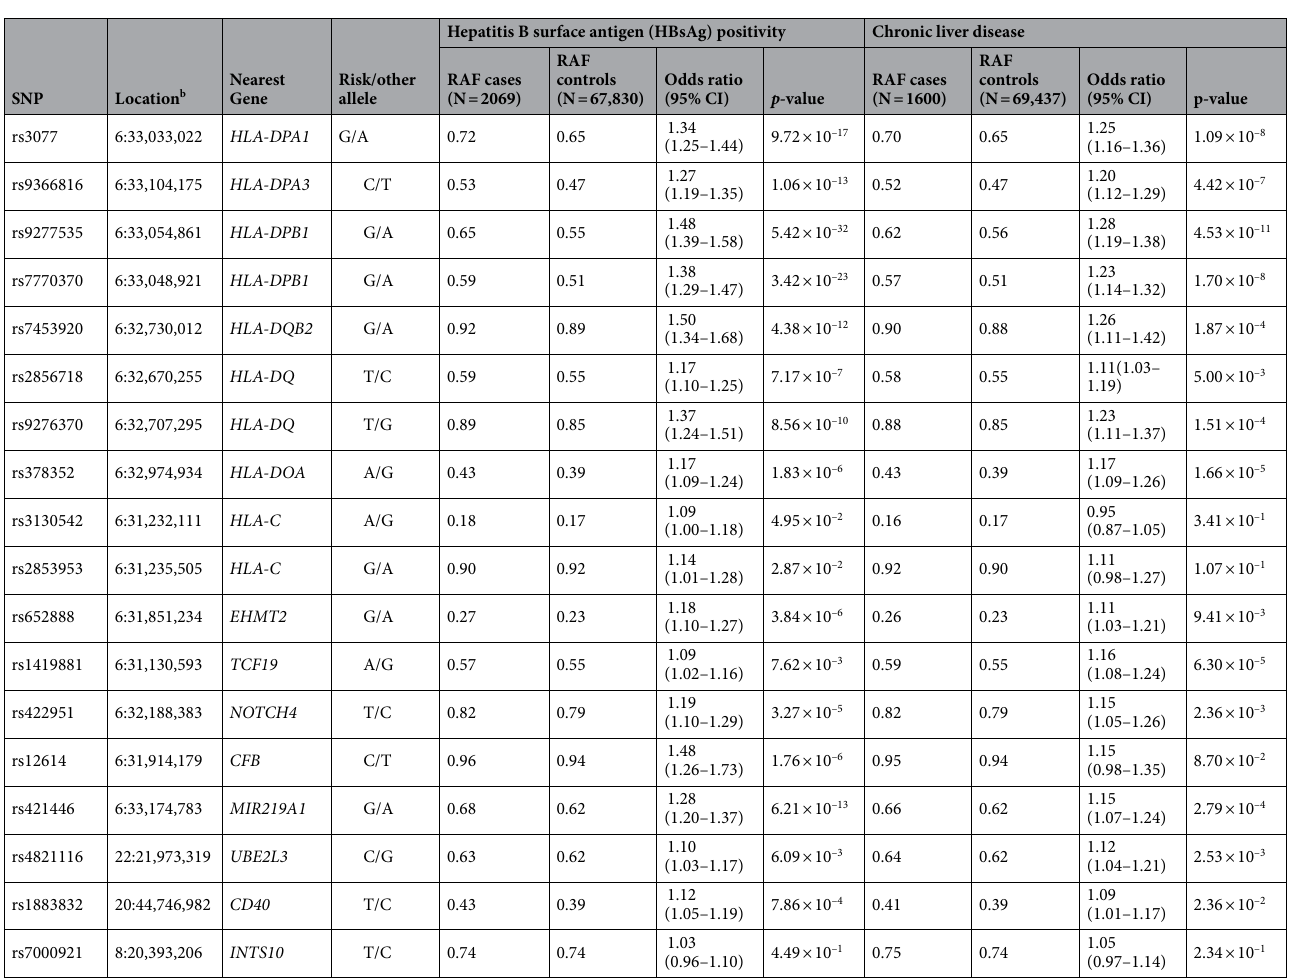
Table 3. Genetic variant associations of select SNPs with HBsAg positivity and chronic liver disease a . HBsAg, hepatitis B surface antigen; SNP, single nucleotide polymorphism; RAF, risk allele frequency. a Chronic liver disease includes prevalent liver disease (chronic viral hepatitis B, cirrhosis or liver cancer) and incident liver disease (liver cancer C22, Liver cirrhosis (including: alcoholic liver disease, fibrosis and cirrhosis of